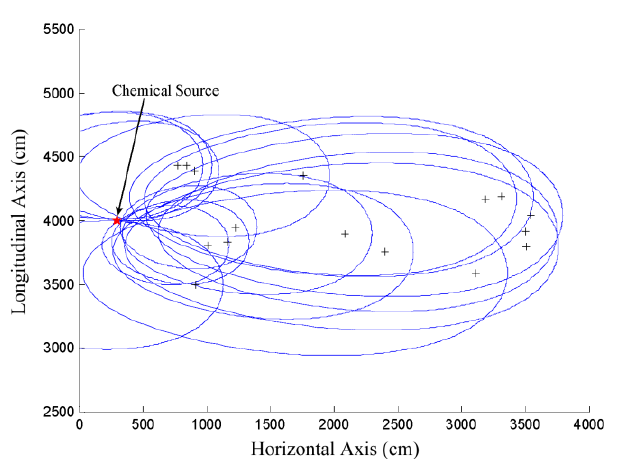
Figure 5. The positional relationship between the actual chemical source location and the points in different refined sample spaces, i.e. , , [1, ] S i l  , which are represented by i different ovals. The sensor nodes are denoted as crosses. The simulation setup used to generate this figure is the same as that used in generating Figure 2, which will be detailed in Section